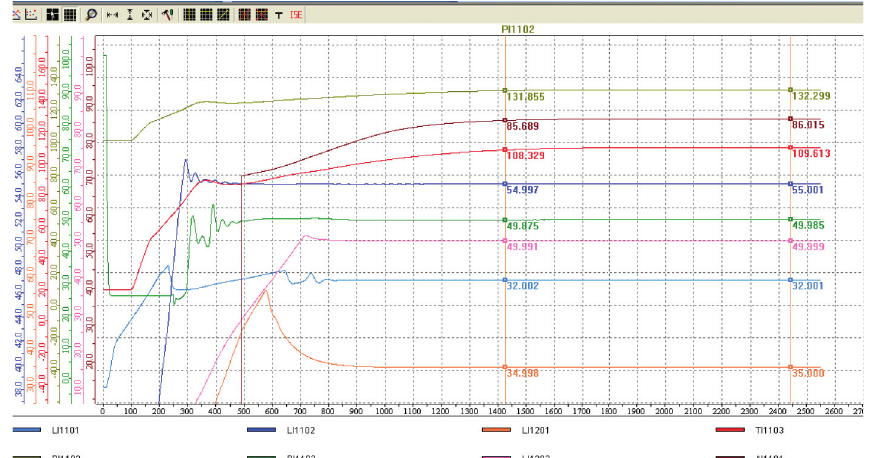
Figure 14: Improved automatic disturbance rejection control after modification of the control object model parameters.